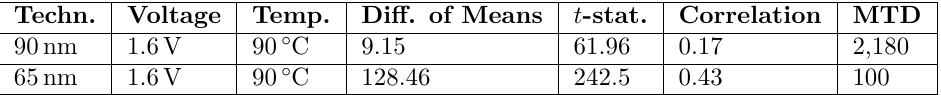
Figure 6: Leakage evaluation and attack using 50,000 fixed vs. random measurements of a nibble-serial implementation of the PRESENT-80 block cipher in 65 nm CMOS technology, recorded at 90 ◦ C and 1 . 6 V. Table 2: Comparison of PRESENT block cipher implementation leakage in 65 nm vs. 90 nm technology for best case operating conditions (adversaries point of view).